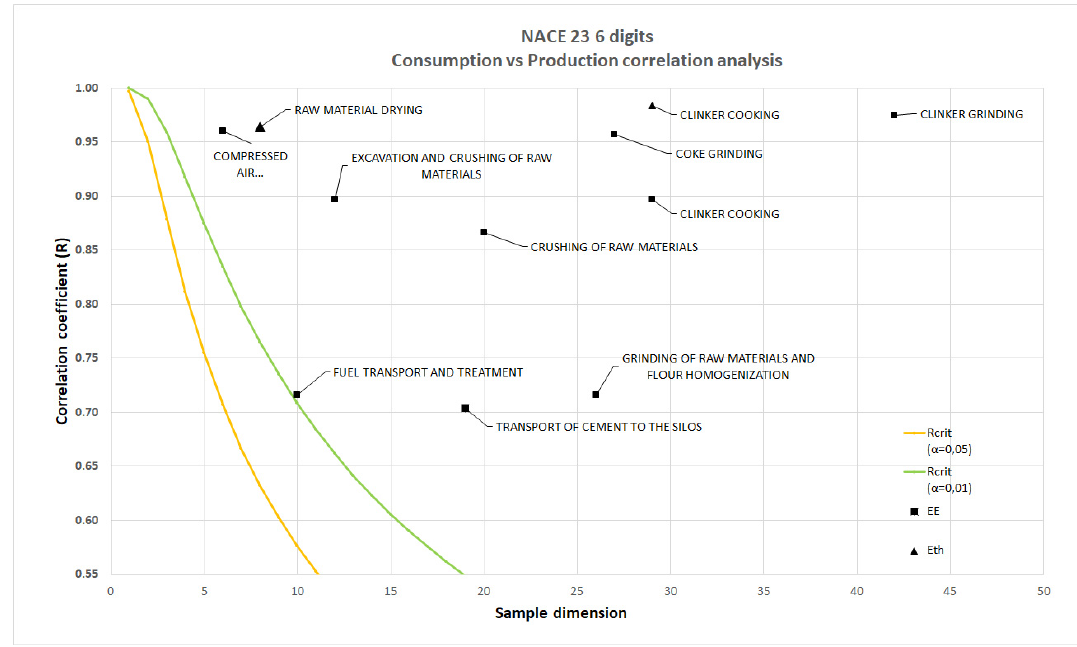
Figure 23. NACE 23.51: consumption vs. production correlation analysis for the main production phases and auxiliary services.